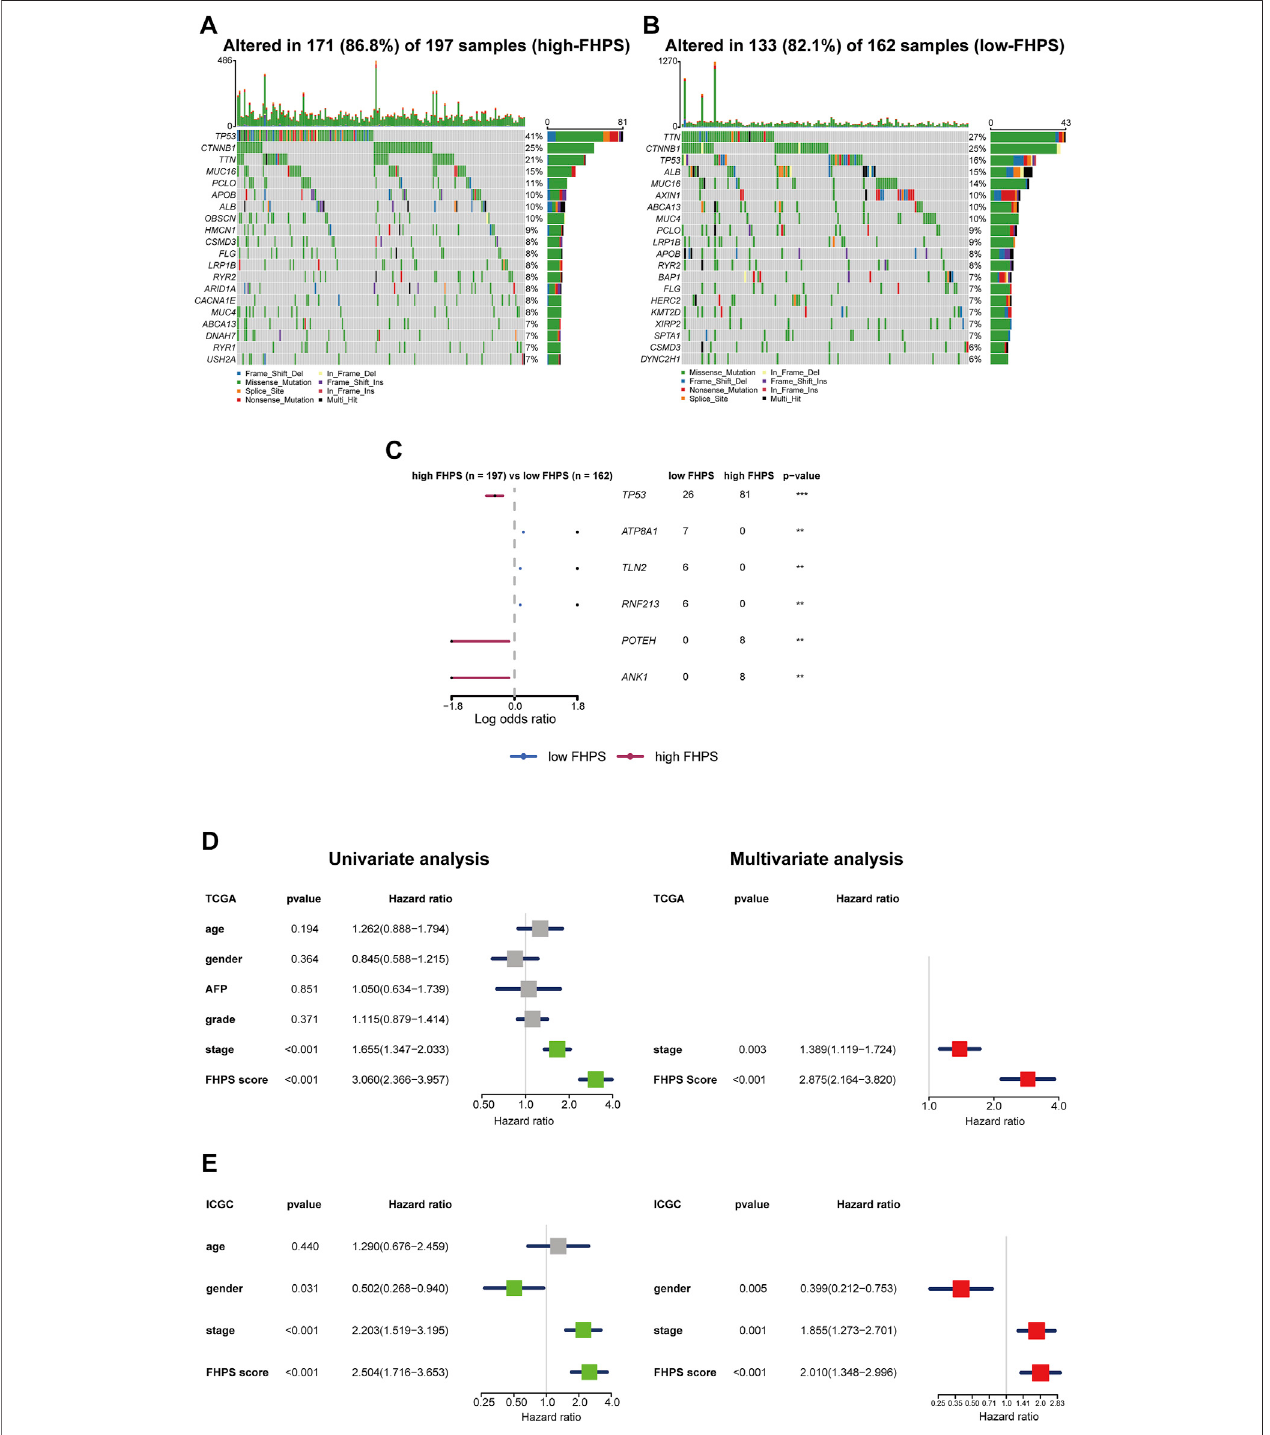
FIGURE8|(A, B) Oncoplots ofthemutated genesin the (A) high-FHPS and (B) low-FHPS groupsoftheTCGA cohort. (C) Forest plotofthedifferentially mutated genes between the high- and low-FHPS groups. (D, E) Univariate and multivariate analyses revealed that FHPS score was an independent prognostic predictor in the TCGA and ICGC cohorts. * p < 0.05; ** p < 0.01; *** p < 0.001; **** p < 0.0001.